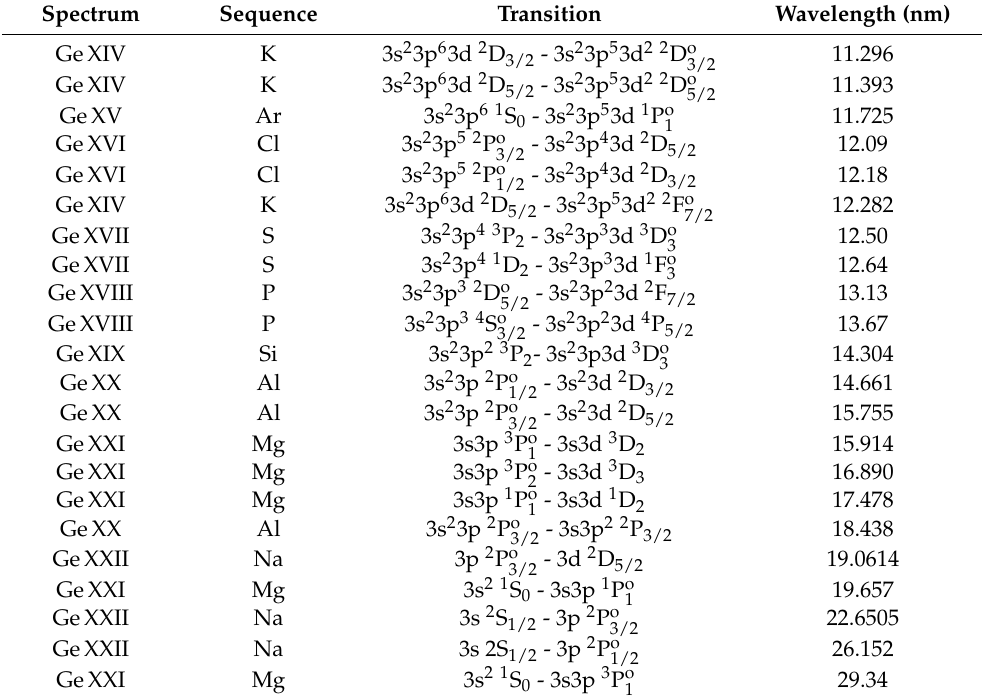
Table 1. Representative transitions in Na- through K-like ions of Ge as available in the Kelly tables of 1987